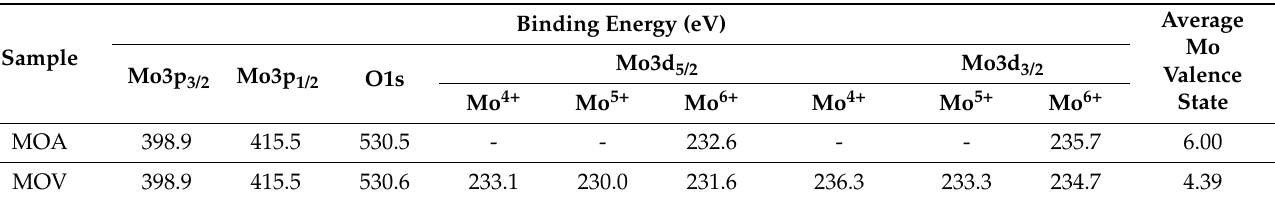
Table 3. XPS analysis of the MOA and MOV